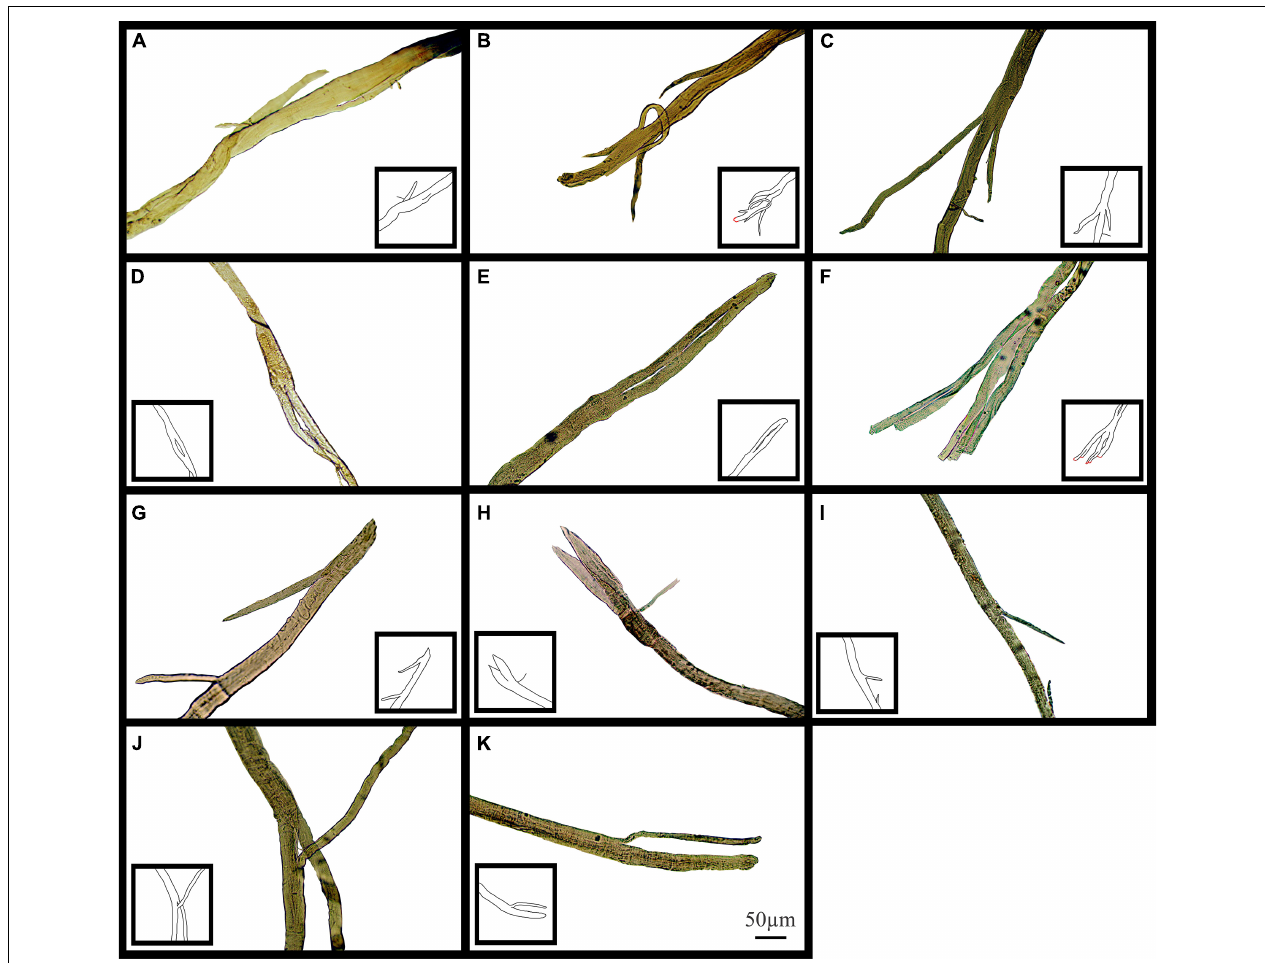
FIGURE 10 | Examples of medium power light microscope images (X100) of muscle fiber branch point sections that have not undergone EC from adult and senescent mdx mice. Cartoon inserts have been added to help visualize the various examples of branching in each image. (A–F) Are portions of fibers from a 22-month mdx mouse EDL. (G–K) Are portions of fibers from an 18-month mdx mouse EDL. Scale bar provided at 50 µ m in (K) applies to all of